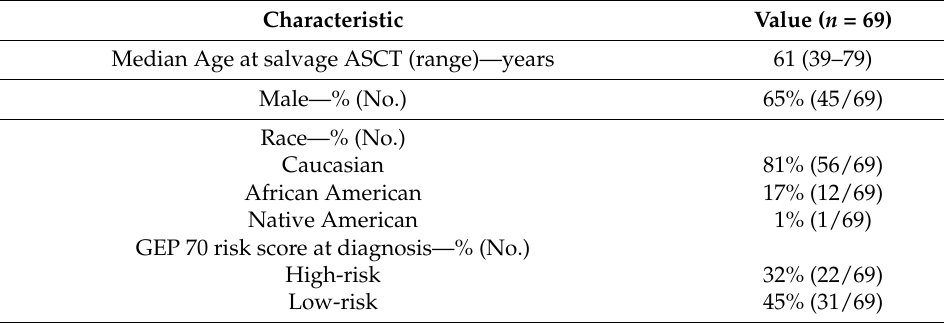
Table 1. Patient